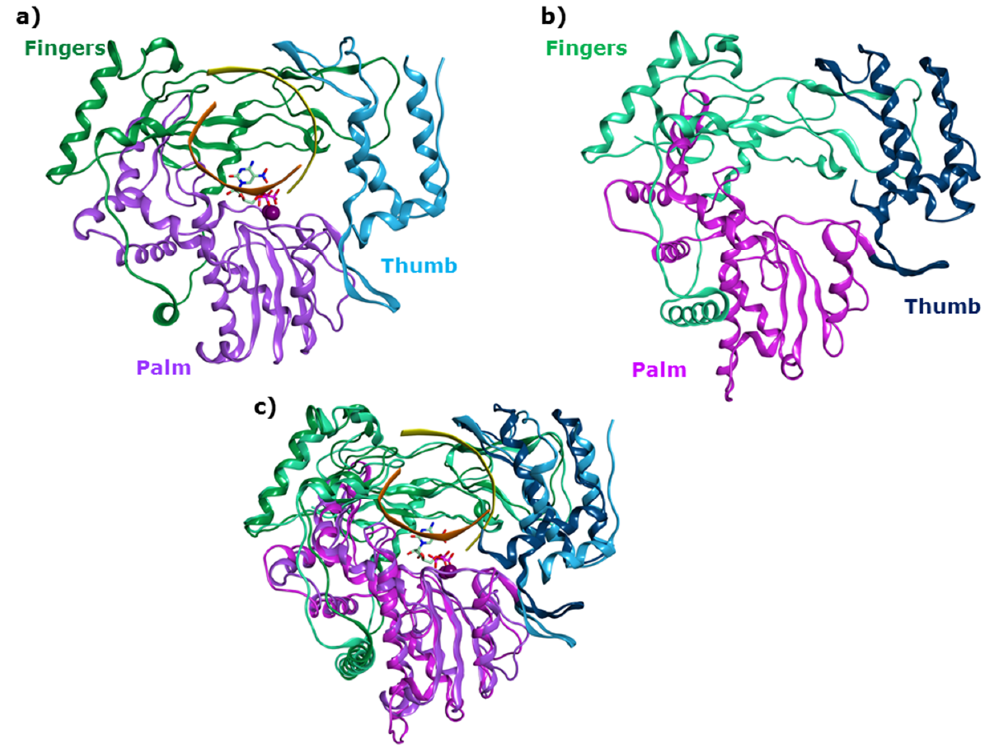
Figure 1. ( a ) Three-dimensional structure and domains of HNoV RdRp (Norwalk virus, GI.1) in complex with RNA template strand, RNA growing strand and 5-nitrocytidine (PDB ID 3BSN, resolution 1.8 Å); ( b ) HSaV RdRp (Sapporo virus, Hu/SV/Man/1993/UK) in its apo form (PDB ID 2CKW, resolution 2.3 Å); ( c ) structural superimposition of the two RdRps.